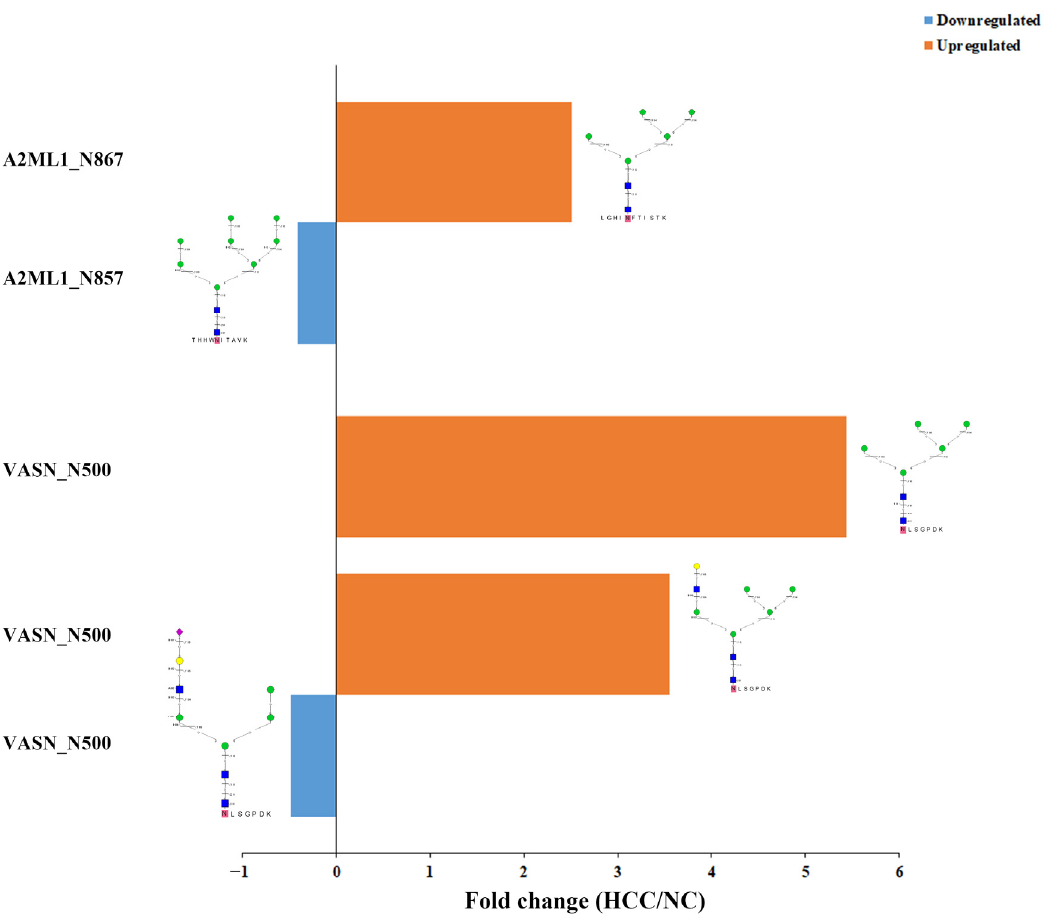
Figure 6. Simultaneous up- and down-regulation on alpha-2-macroglobulin-like protein 1 (A2ML1_HUMAN, A8K2U0) and vasorin (VASN_HUMAN, Q6EMK4) with different intact N-gly-